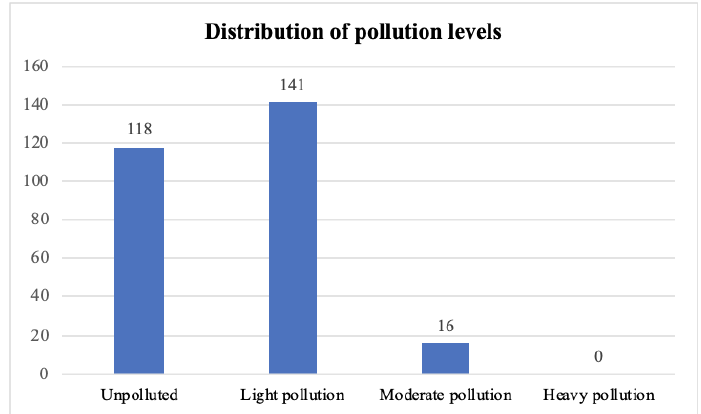
Figure 8. The distribution of labelling pollution